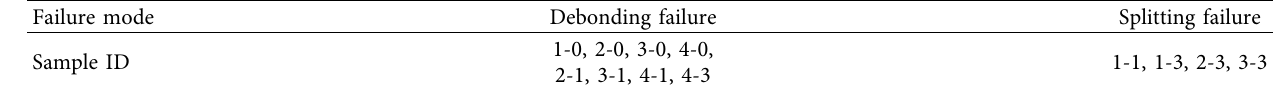
Table 3: Failure modes of the samples.